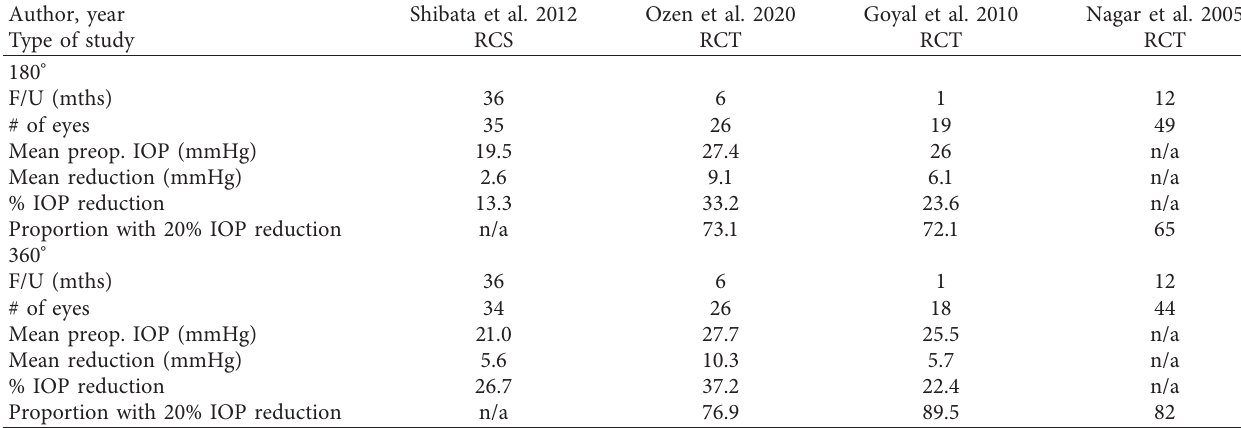
Table 1: Comparison of the main outcomes of past studies comparing 180 ° and 360 ° of